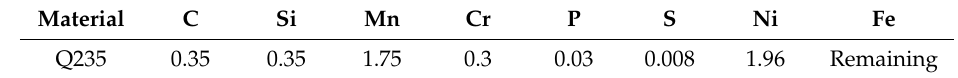
Figure 1. Composition of underwater welding X-ray high-speed camera system. 1—lead housing; 2—X-ray source; 3—test bench; 4—X-ray image intensifier; 5—welding wire; 6—high-speed camera; 7—console. Table 1. Chemical composition of Q235